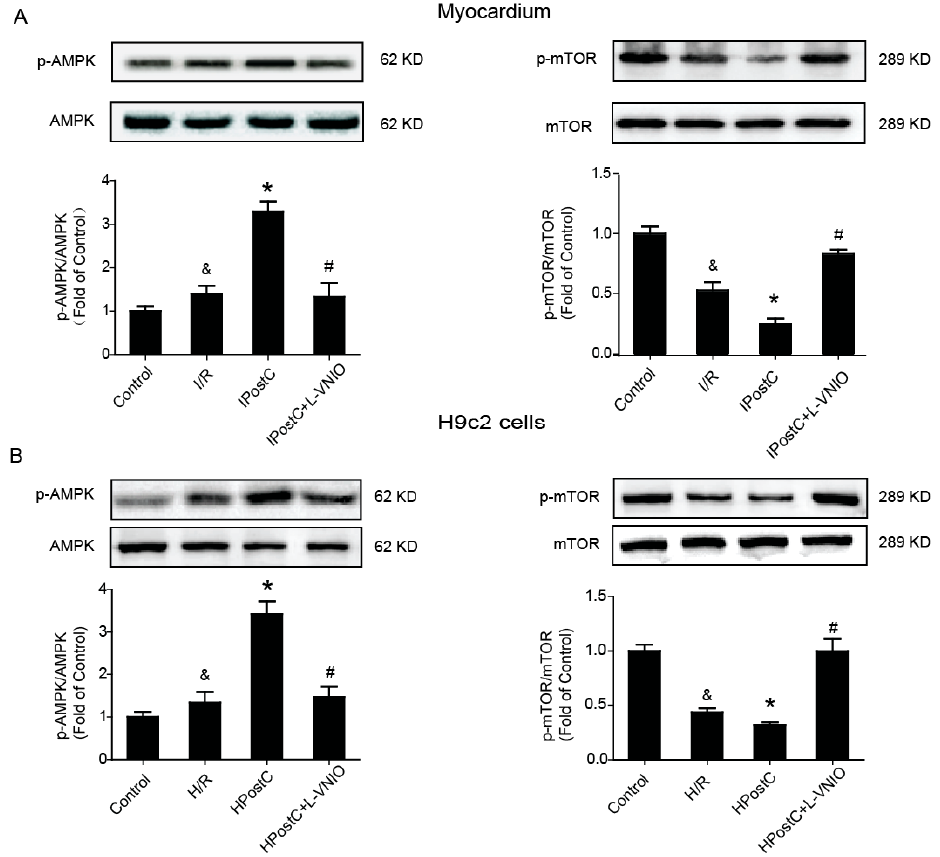
Figure 4. IPostC activated the nNOS/AMPK/mTOR signaling pathway during early reperfusion. ( A ) The protein expression and optical density analysis of p-AMPK (Thr172)/AMPK, p-mTOR(Ser2448)/mTOR in the myocardium at 30 min of reperfusion; ( B ) Expression of p-AMPK, p-mTOR in H9c2 cells at 30 min of reoxygenation. & p < 0.05 versus control, * p < 0.05 versus I/R, # p < 0.05 versus IPostC. The mean values ± SEM, n = 6.